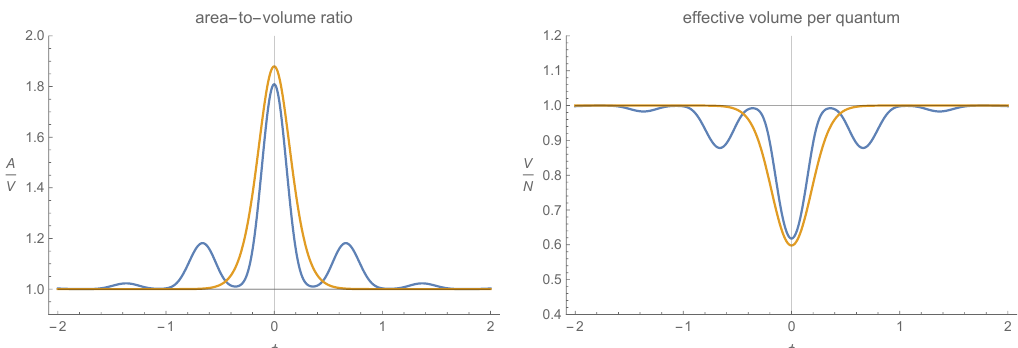
Figure 6. The surface-area-to-volume ratio ( left ) and the effective volume per quantum ( right ) as a function of relational time. These figures demonstrate the degenerate character of the quantum geometry towards the bounce and the damping of the anisotropies in the outgoing phase. The plots were taken from Ref. [58] where detailed explanations are